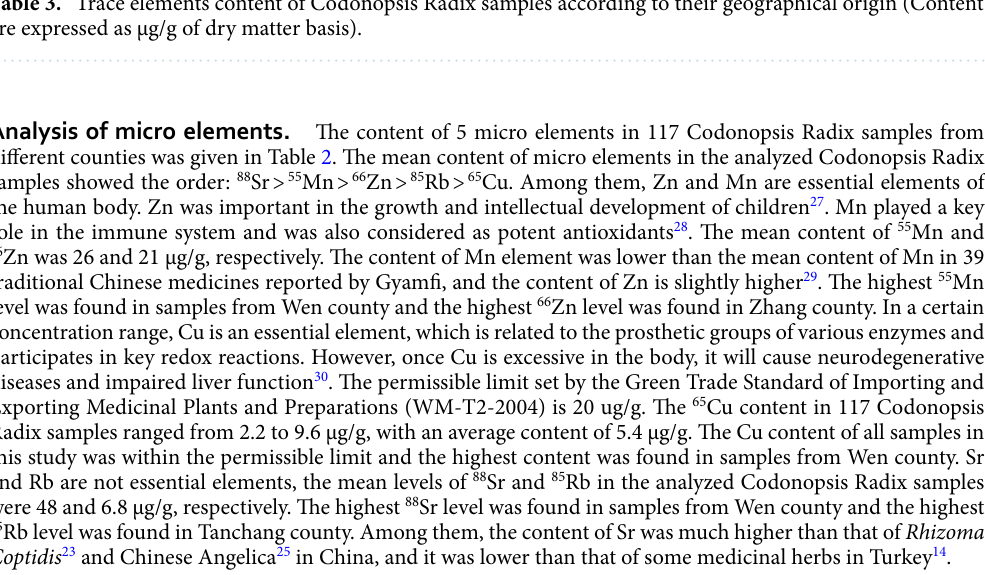
Table 3. Trace elements content of Codonopsis Radix samples according to their geographical origin (Content are expressed as μg/g of dry matter basis).